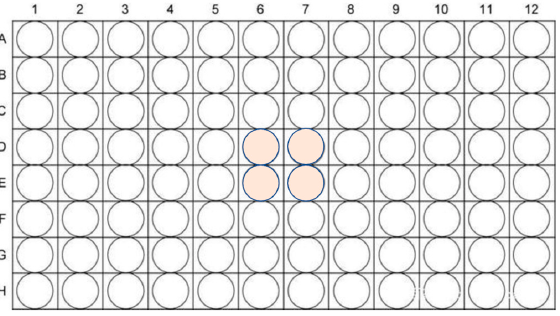
Figure 3. Layout of duplicated wells (marked in pink) in 96-well plate.